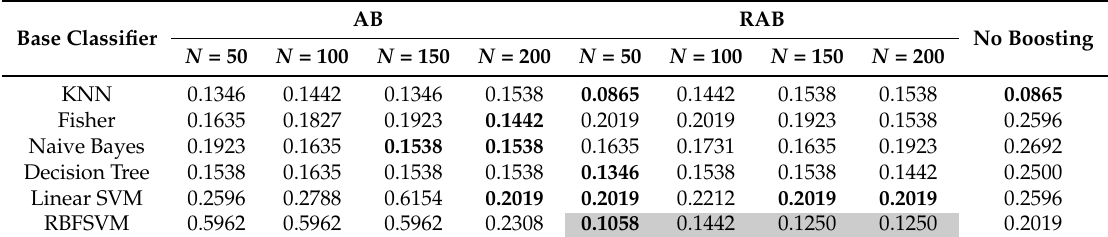
Table 3. Errors of AdaBoost and Robust AdaBoost with different component classifiers (Bold numbers show the lowest errors of AdaBoost, Robust AdaBoost and classifier without